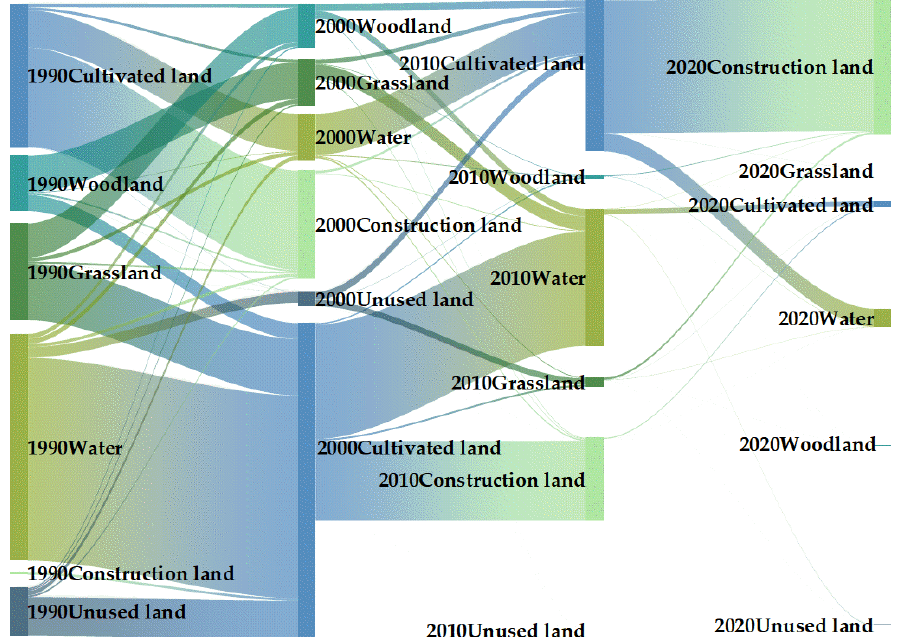
Figure 4. Quantitative change track of land use types in the Yellow River Basin (Henan section) from 1990 to 2020. Note: The curve of the Sankey diagram represents the transfer between landscape types, and the thickness of the curve represents the amount of transfer. The thicker the curve is, the greater the amount of transfer, and the thinner the curve is, the smaller the amount of transfer.